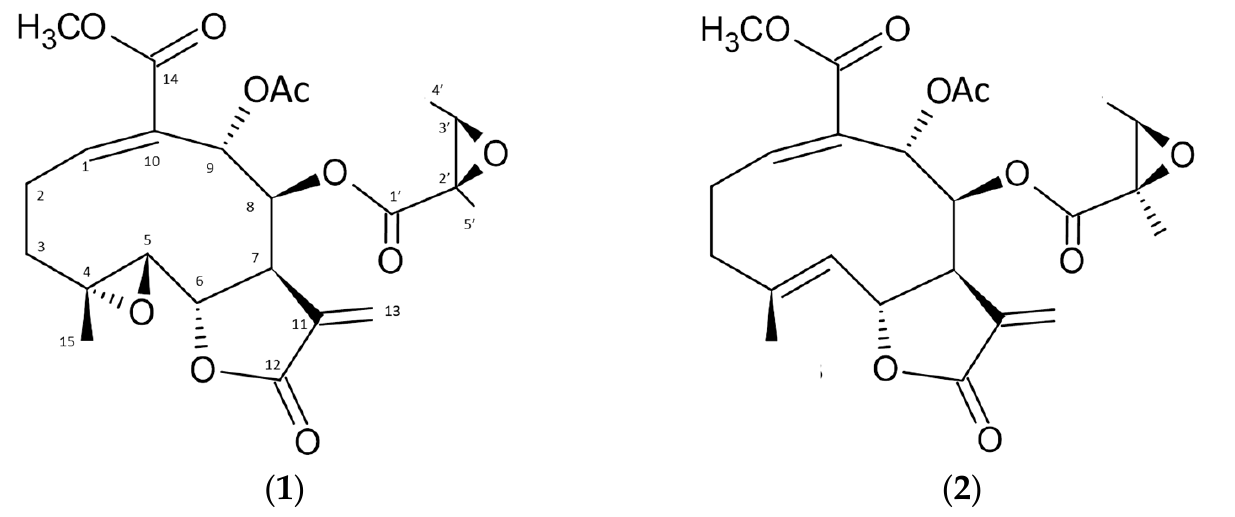
Figure 2. Chemical structure of enhydrin ( 1 ) and uvedalin ( 2 ). Table 1. 13 C NMR spectral data of compounds 1 and 2 compared to a standard reference [22,23]. δ C of Position